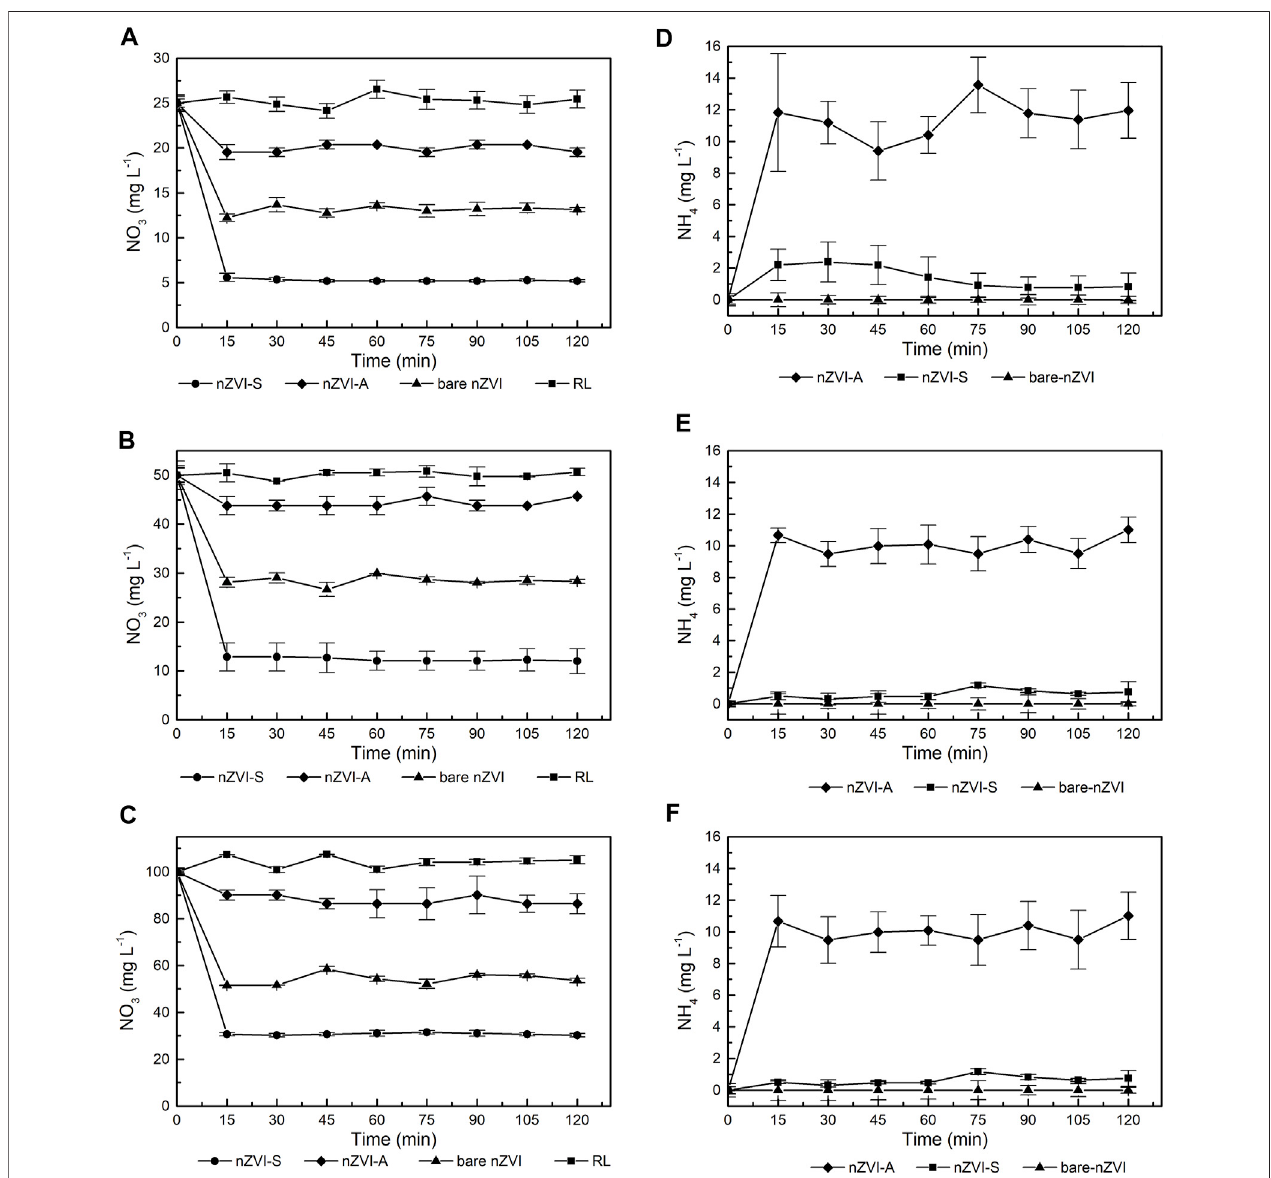
FIGURE7| EffectoftimeandinitialnitratesconcentrationonnitratesreductionusingnZVIatpH4 (A) 25 mg/LNO 3 (B) 50 mg/LNO 3 (C) 100 mg/LNO 3 andeffect of time and initial nitrates concentration on ammonia concentration using nZVI at pH 4 (D) 25 mg/L NO 3 (E) 50 mg/L NO 3 (F) 100 mg/L NO 3 .